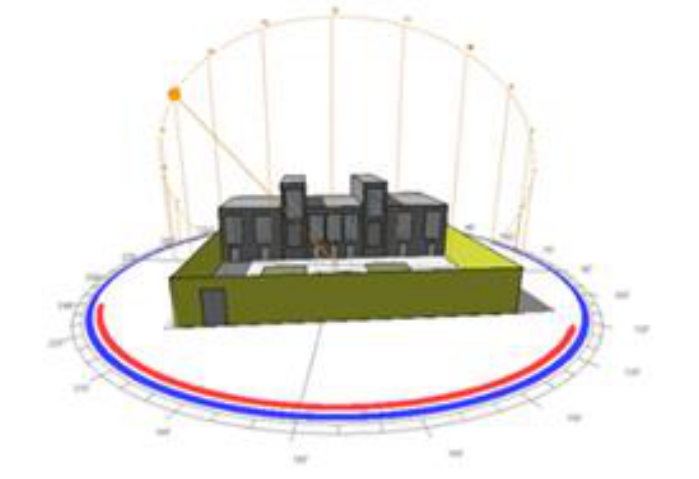
Figure 22 3D view of house No.5 (July, 16:00